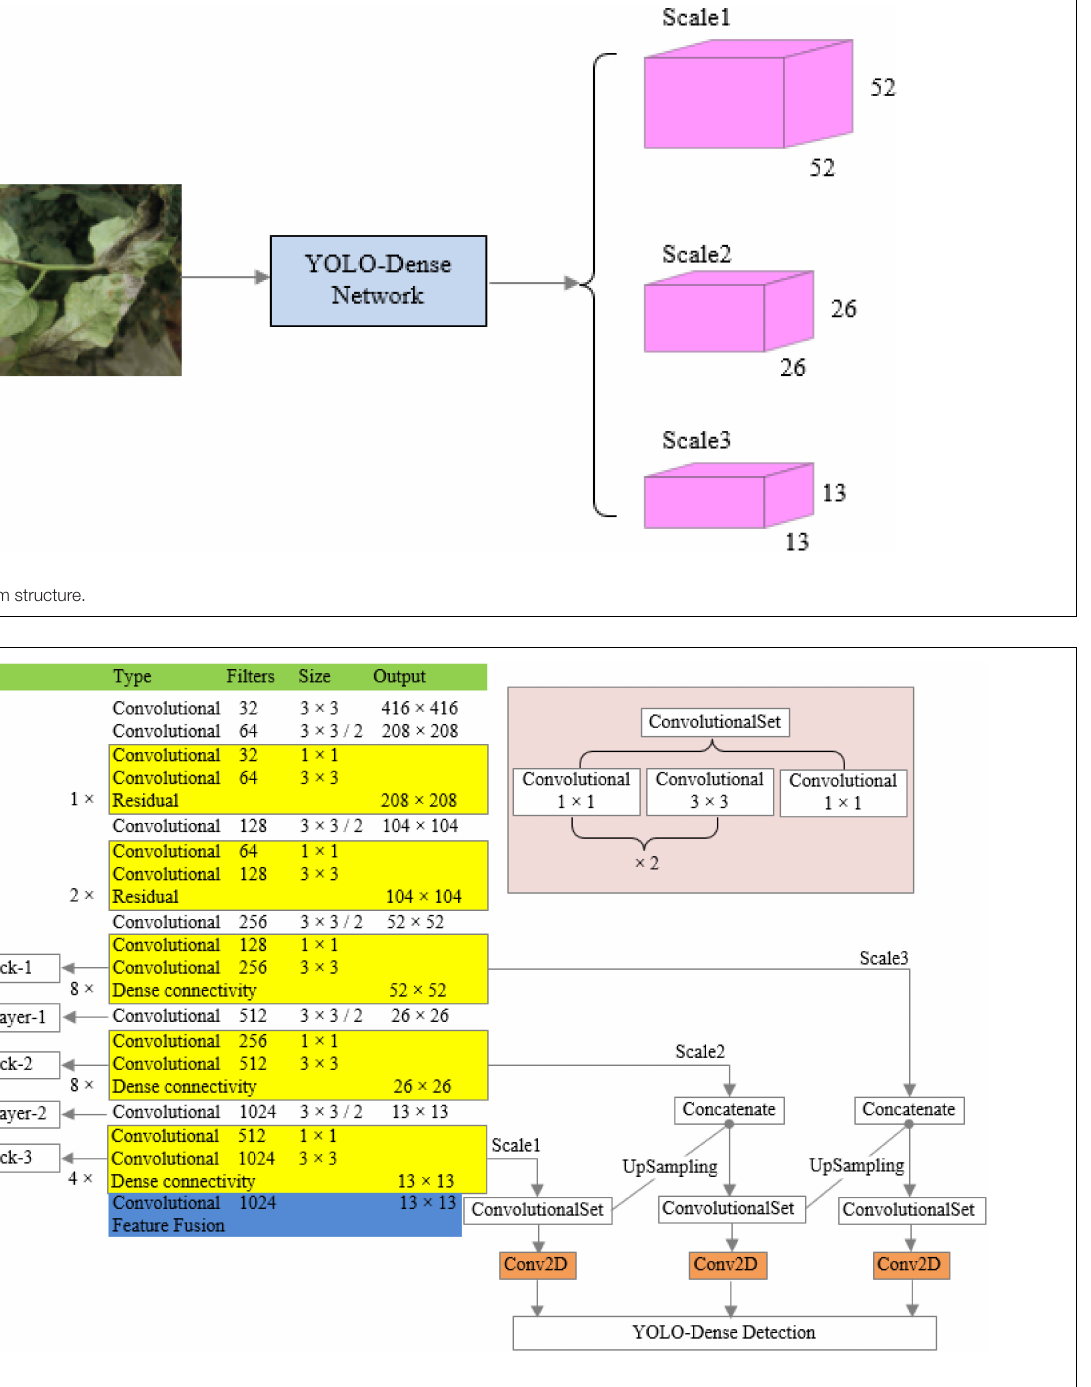
FIGURE 3 | YOLO-Dense network